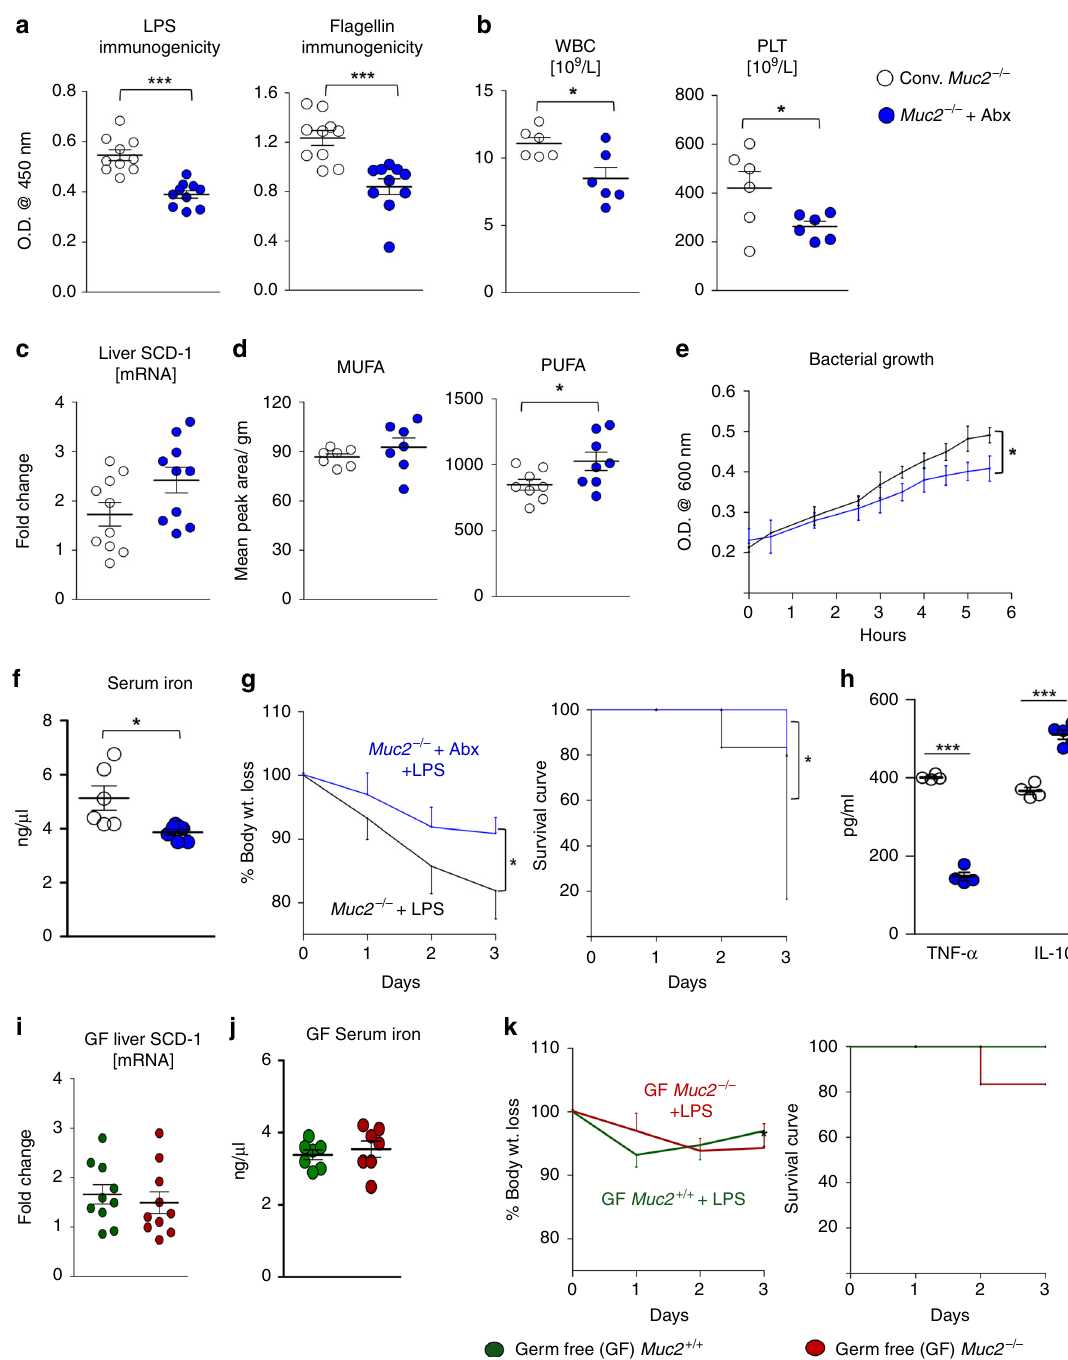
3 weeks. Intestinal permeability was measured by FITC dextran 23 . Serum LDH, ELISA, and iron assay . All assays were performed using hemolysis- free sera, which were collected by centrifugation of blood in serum separator tubes (BD Biosciences, USA). Serum LDH levels were determined by colorimetric LDH assay kit (Abcam, ON, Canada) as per manufacturer ’ s protocol. Serum lipocalin 2 was detected and quanti fi ed using mouse lipocalin 2 duoset ELISA kit (R&D systems; Catalog No. DY1857-05). Levels of anti- fl agellin and LPS antibodies in serum was detected by ELISA 58 . Serum cytokine levels were measured using luminex (Eve technologies, University of Calgary, Calgary). Total iron content was quanti fi ed using hemolysis-free sera and from saline-perfused liver samples from animals. Iron quanti fi cation kit (Sigma, USA) was used to determine total iron content following manufacturer ’ s